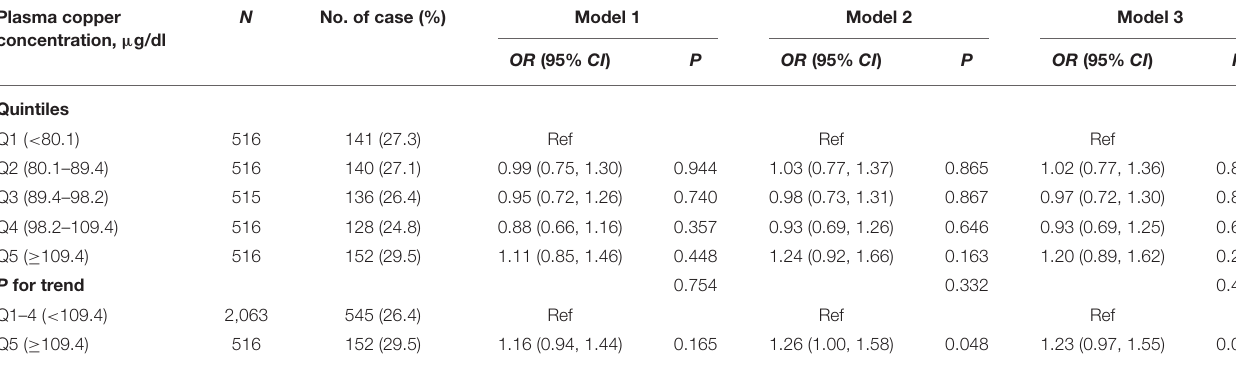
TABLE 2 | The association between plasma copper concentration and prevalence of diabetes in 2,579 Chinese adults with hypertension a . N No. of case (%) Model 1 Model 2 Plasma copper concentration, µ g/dl OR (95% CI ) P OR (95% CI ) P OR (95% CI ) P Quintiles Q1 ( <